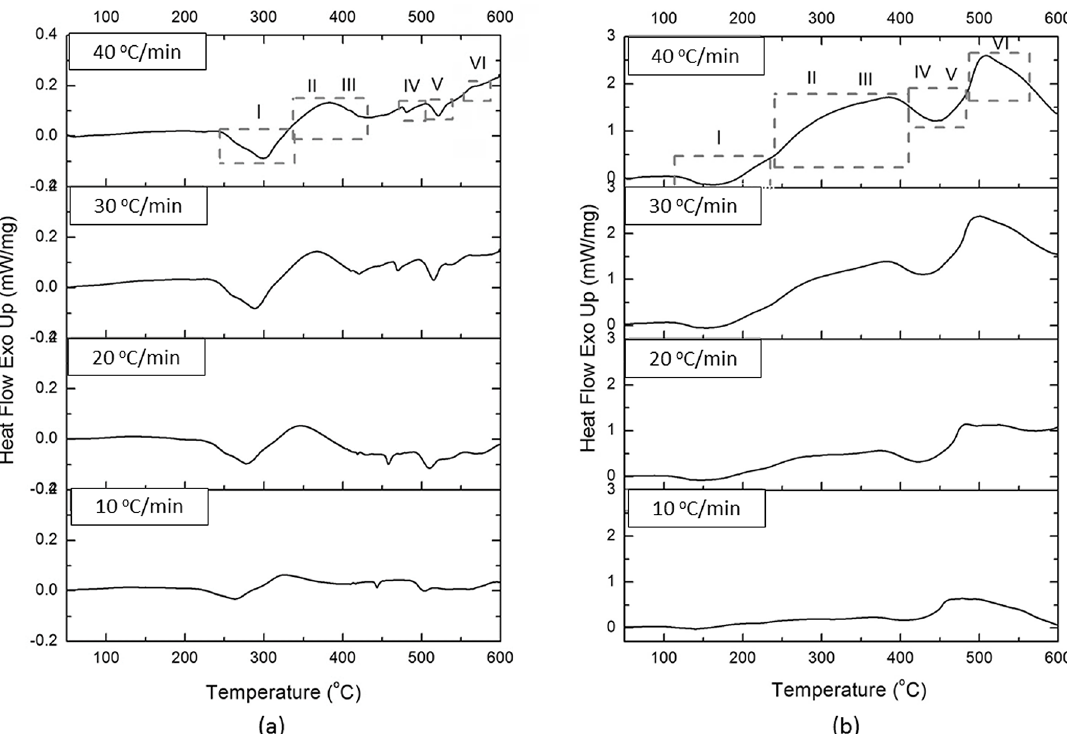
Figure 4. DSC curves for (a) as-received atomized powder and (b) powder milled for 8 h, measured using heating rates of 10, 20, 30, and 40 °C/min.